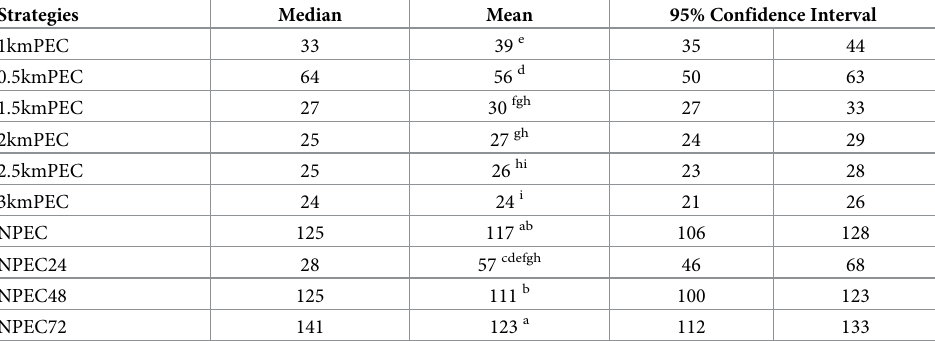
Means with different superscripts in each column were statistically different.